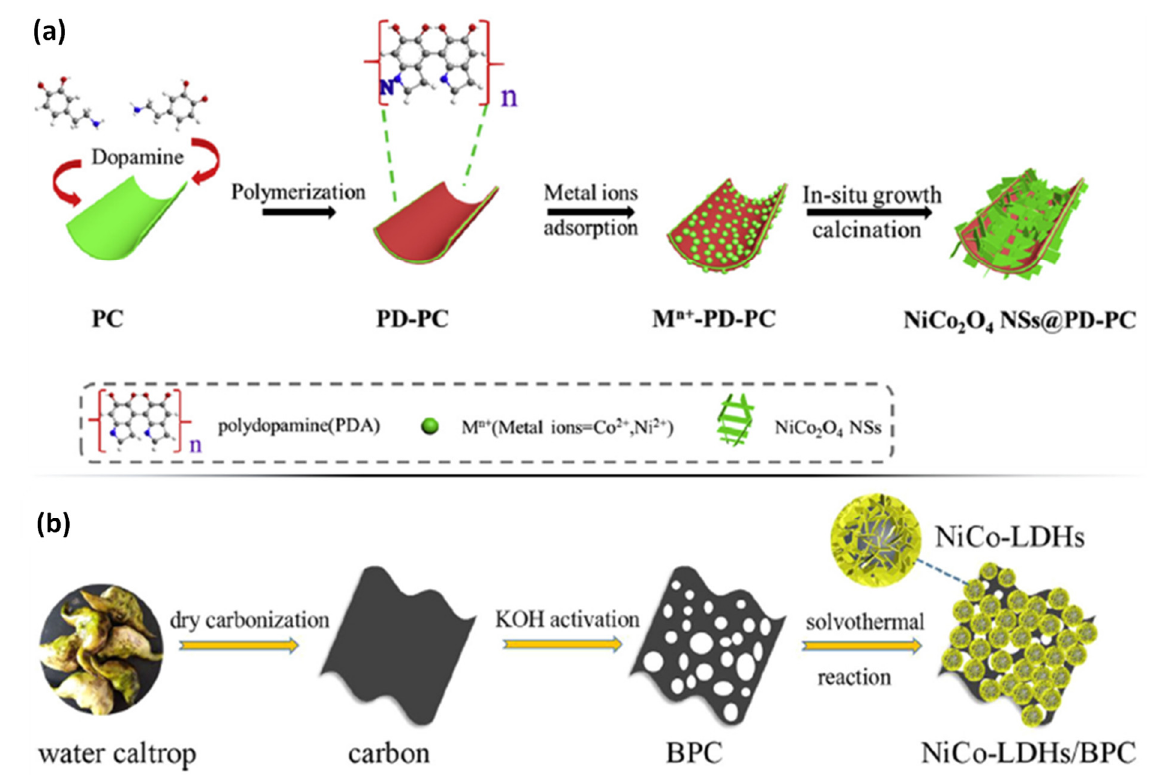
Figure 6. Selected examples of synthetic protocols for obtaining Ni-Co/biomass-derived-carbons via post-carbonization functionalization approach ( a ) [113] ( b ) [115]. Abbreviations: ( a ) PC: carbonized poplar catkins micro-hollow fibers, PD: polydopamine, and NSs: nanosheets; ( b ) BPC: biomass porous carbon, and LDHs: layered double hydroxides. Reprinted from [113], Copyright (2019), with permission from Elsevier ( a ). Reprinted from [115], Copyright (2020), with permission from Elsevier ( b ).